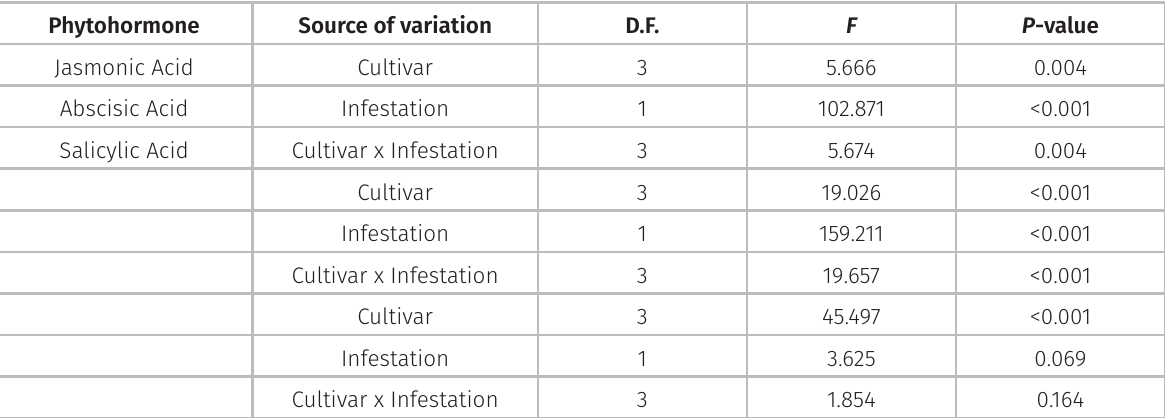
Table I. Two-way anova parameters for phytohormes of forage grasses exposed to M. spectabilis herbivory. Phytohormone Source of variation Jasmonic Acid Abscisic